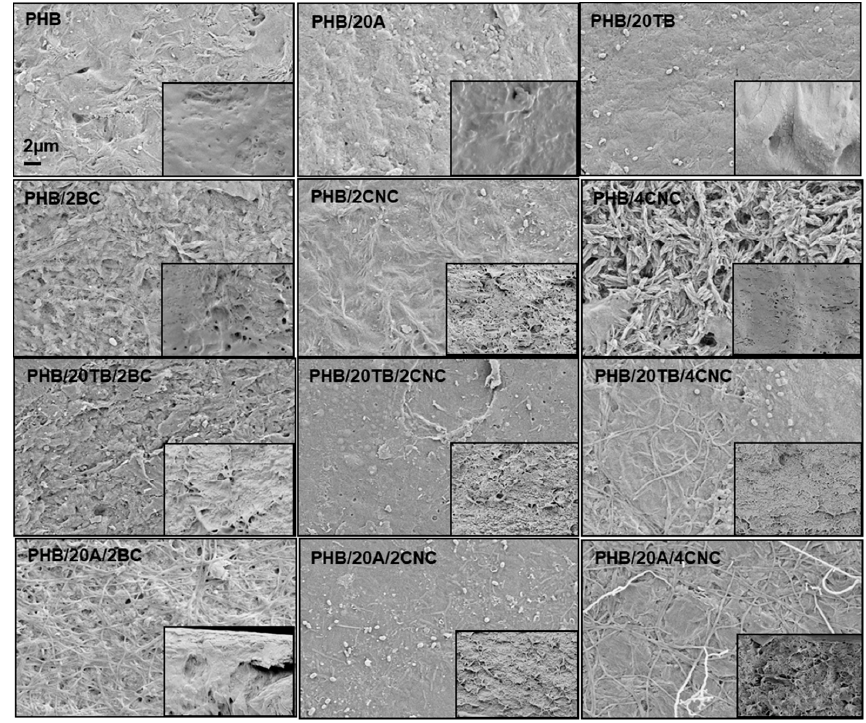
Figure 9. FESEM images of disintegrated samples after 14 days under composting conditions.